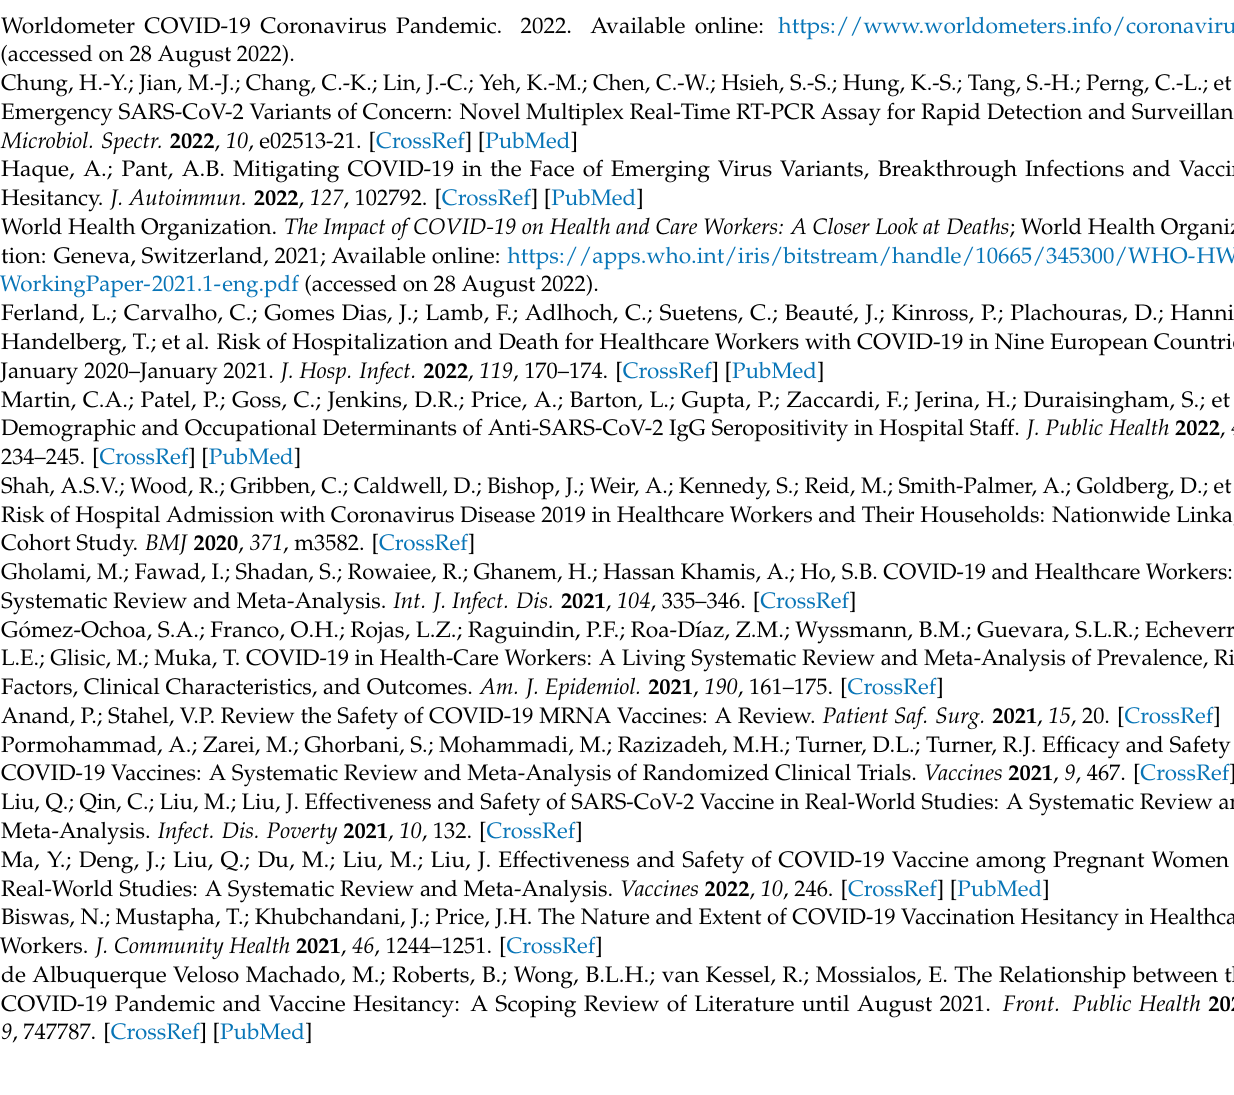
were conducted; Table S1: Overview of the studies included in systematic review. Table S2: Quality of studies included in this systematic review; Table S3: COVID-19 vaccine uptake among healthcare workers. Table S4: Measures of effect and precision between predictors and COVID-19 vaccine uptake among healthcare workers. Table S5: Measures of effect and precision between predictors and COVID-19 vaccine uptake among healthcare workers